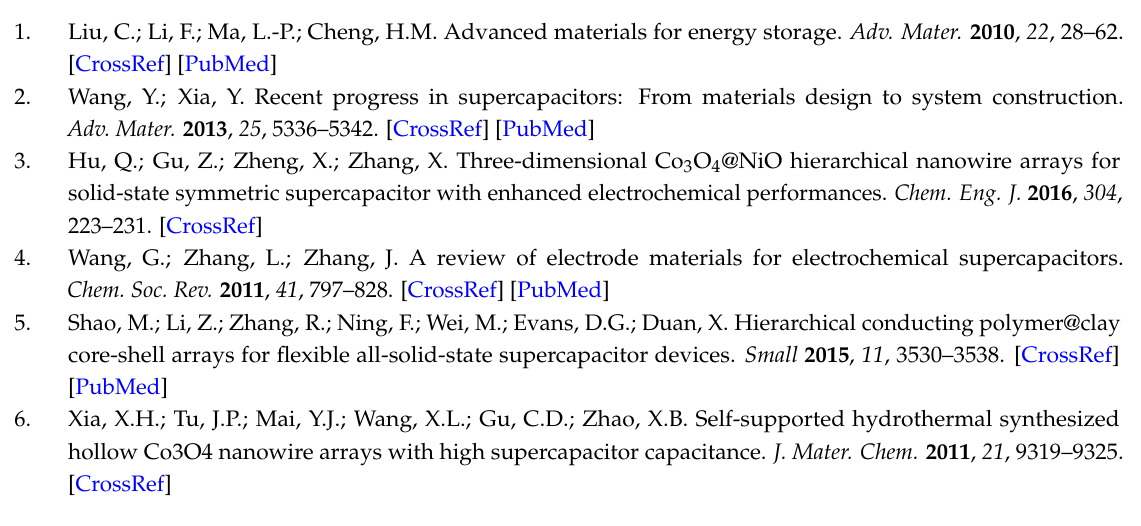
Figure S1: SEM images of (a) CC; (b) Co 3 O 4 -100s/CC; (c) Co 3 O 4 -200s/CC; (d) Co 3 O 4 -300s/CC; (e) Co 3 O 4 -400s/CC; (f) Co 3 O 4 -500s/CC; Figure S2: (a) CV curves of the Co 3 O 4 /CC measured at 10 mV · s − 1 ; (b) Specific capacitance of the Co 3 O 4 /CC measured at 10 mV · s − 1 ; (c) GCD curves of the Co 3 O 4 /CC measured at 1.0 A · g − 1 ; (d) Specific capacitance of the Co 3 O 4 /CC measured at 1.0 A · g − 1 , Table S1: Comparison of